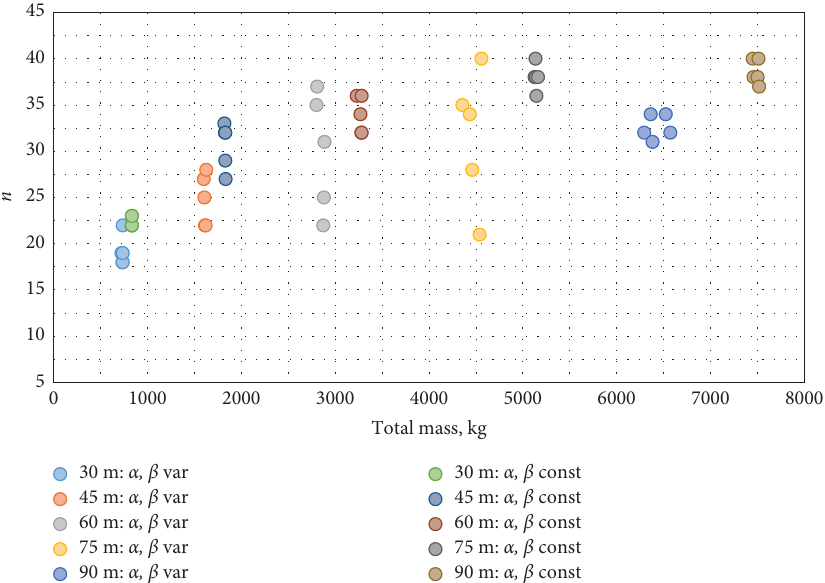
Figure 9: Five best values of section number n at variable and constant angles α and β for all spans.